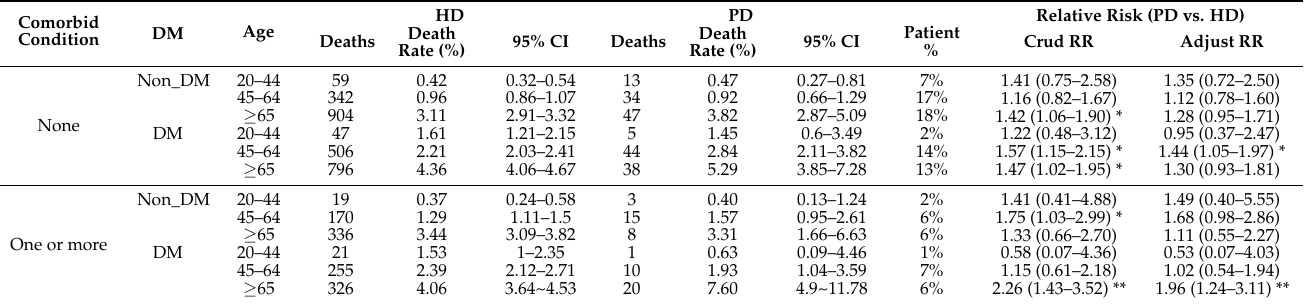
Table 4. Mortality risk by stratifying diabetes mellitus, comorbid condition, and